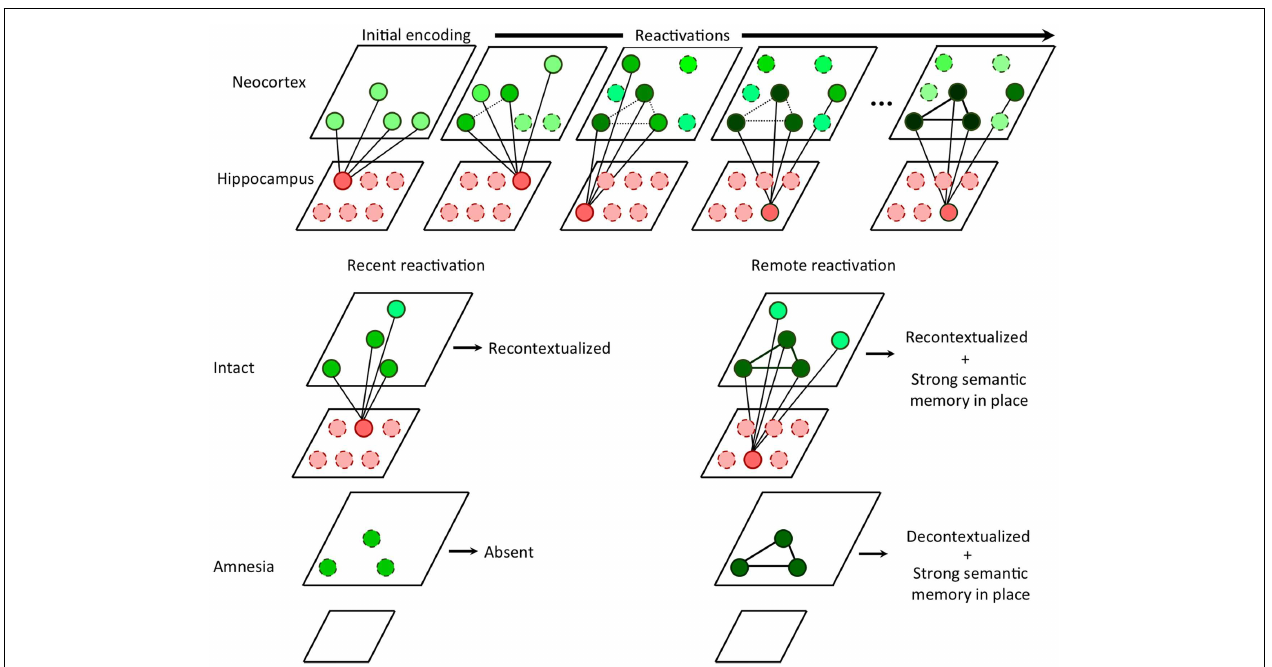
recent memory cannot be retrieved in the absence of the hippocampus, since no features have yet been consolidated. During remote memory reactivation, an intact hippocampus continues to recontextualizes the memory, however, a strong consolidated semantic memory is in place due to a number of prior reactivations. In amnesia, the remote memory can be retrieved at least in part based on the semantic memory. Absent the hippocampus, recontextualization can no longer occur and additionally, the retrieval experience may be less contextual than that of an intact